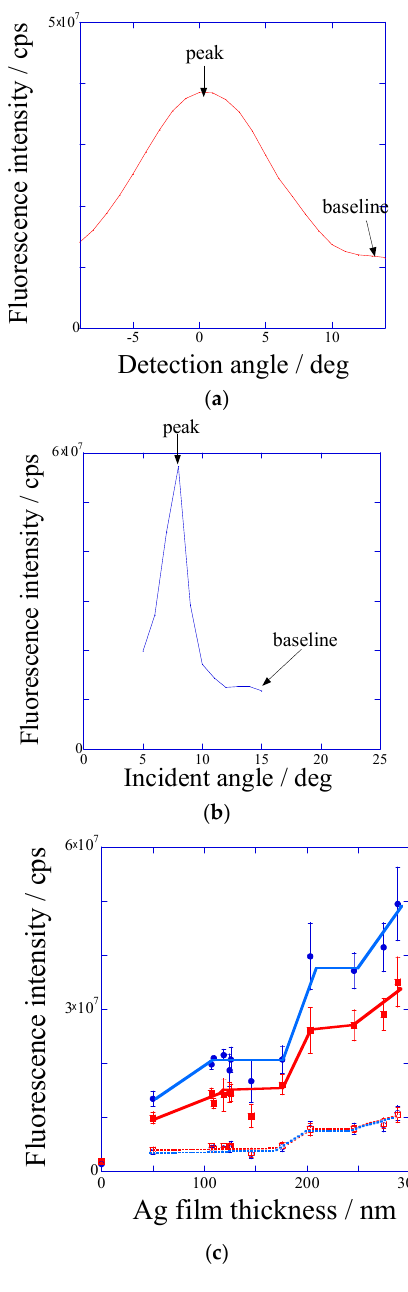
Figure 2. Fluorescence intensities measured ( a ) against the detection angle under the excitation at out-of-resonance angle (DAS) system and ( b ) against the incident angle under the detection at out-of-SPCE (surface plasmon coupled emission) angle (IAS) system; and ( c ) fluorescence intensities plotted against the silver film thickness for the peak values in DAS (red solid line) and IAS (blue solid line) and for the base values in DAS (red broken line) and IAS (blue broken line).